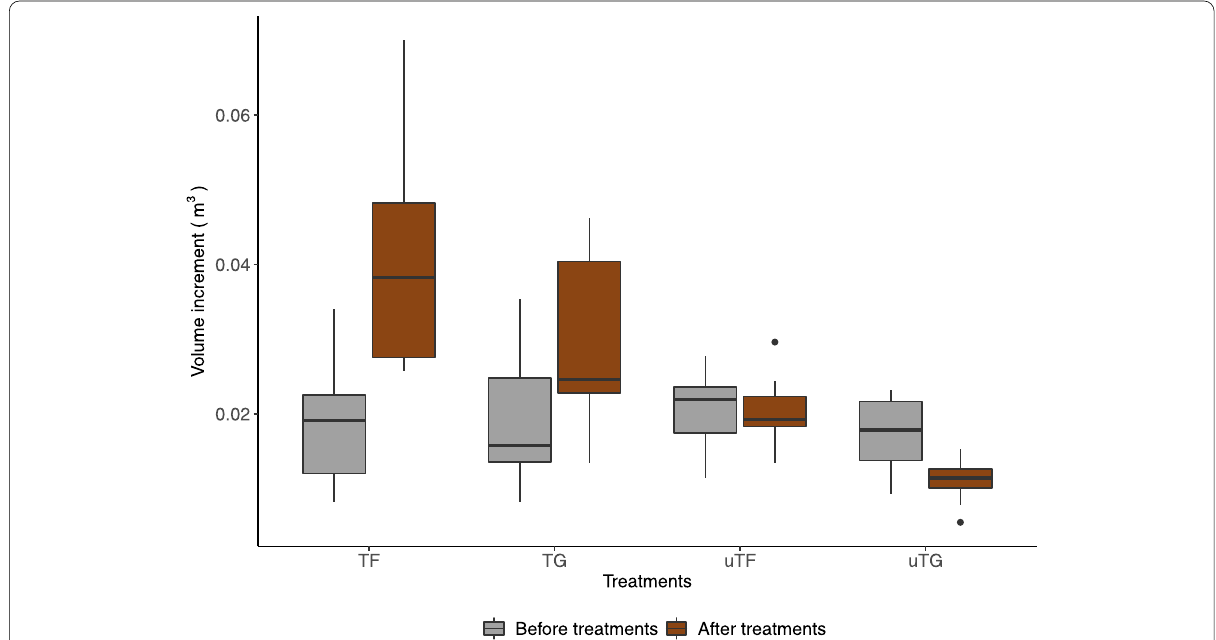
Fig. 2 Stem volume increment below the guy-wiring point before (2011 – 2014) and after (2015 – 2018) thinning. TF stands for thinned free-swaying trees, TG for thinned guy-wired trees, uTF for unthinned free-swaying trees and uTG for unthinned guy-wired